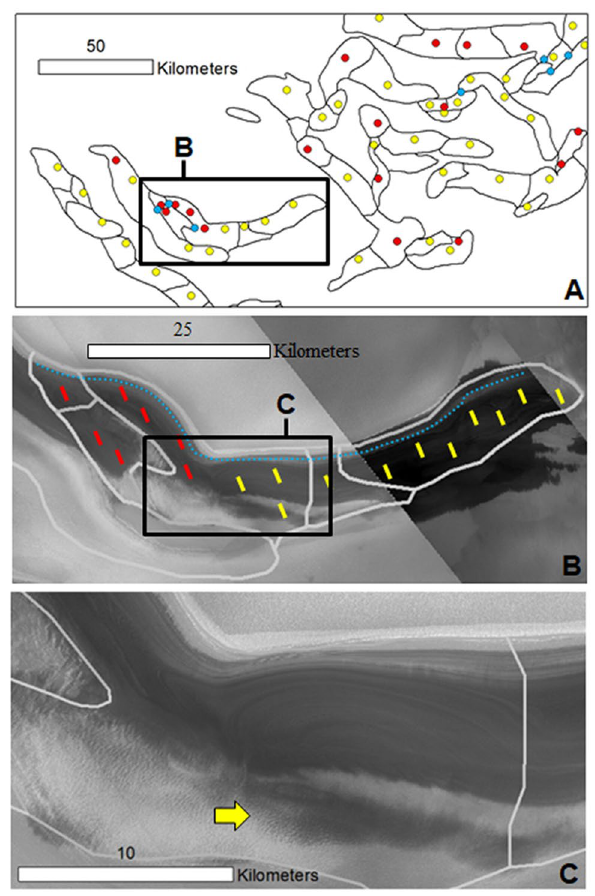
Figure 4. ( A ) View showing a sample of our mapping of the spiral troughs centered at 80°18’ N 19°43’ E. The black lines outline the cells. The red dots and blue dots, respectively, identify cell floors and mounds with both equator- and pole-facing strata. The yellow dots identify cells with only equator-facing strata exposures. ( B ) Close-up view on panel ( A ) showing a trough that includes some cells with interior outcrops that exhibit equator- and pole-facing layers (area marked by red lines) and other cells that show only equator-facing layers (area marked by yellow lines). These areas share some of the uppermost equator-facing slope layers (blue dotted line). ( C ) A close-up view on the trough in panel ( B ) shows a floor zone with equator- and pole-facing layers adjoining an area where mantles cover the pole-facing layers (yellow arrow). Panels ( B ) and ( C ) are parts of